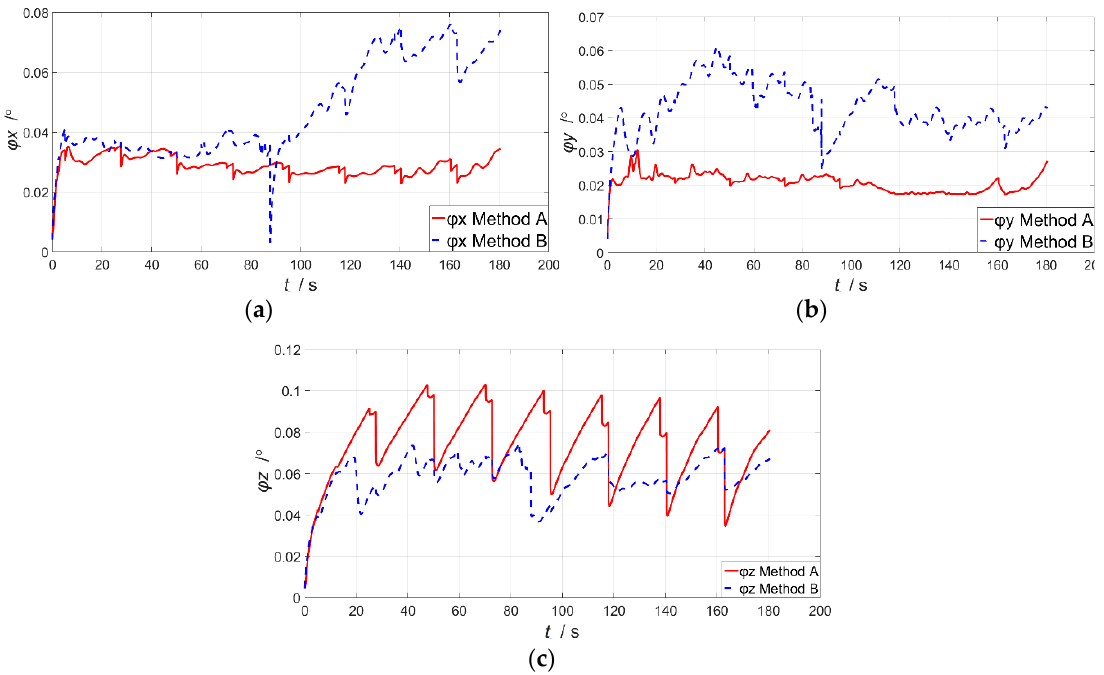
Figure 10. The estimation errors of attitude. ( a ) The x-axis attitude error; ( b ) The y-axis attitude error; ( c ) The z-axis attitude error.